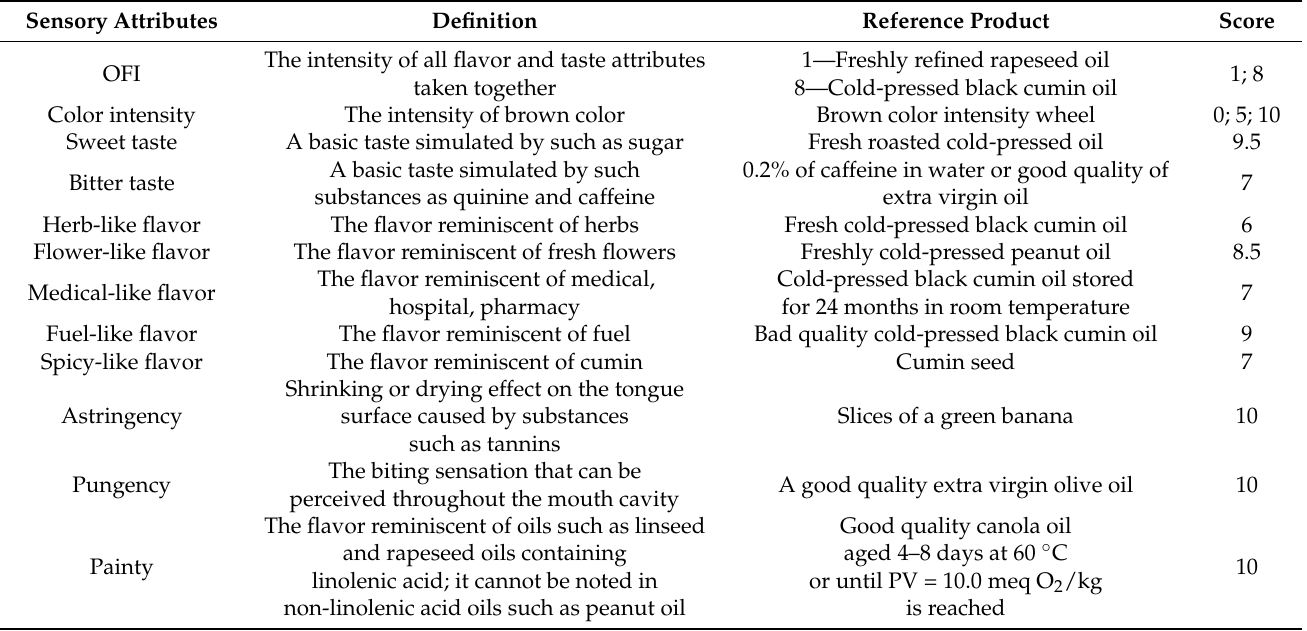
Table 1. Sensory lexicon used for descriptive analysis of cold-pressed black cumin oils.